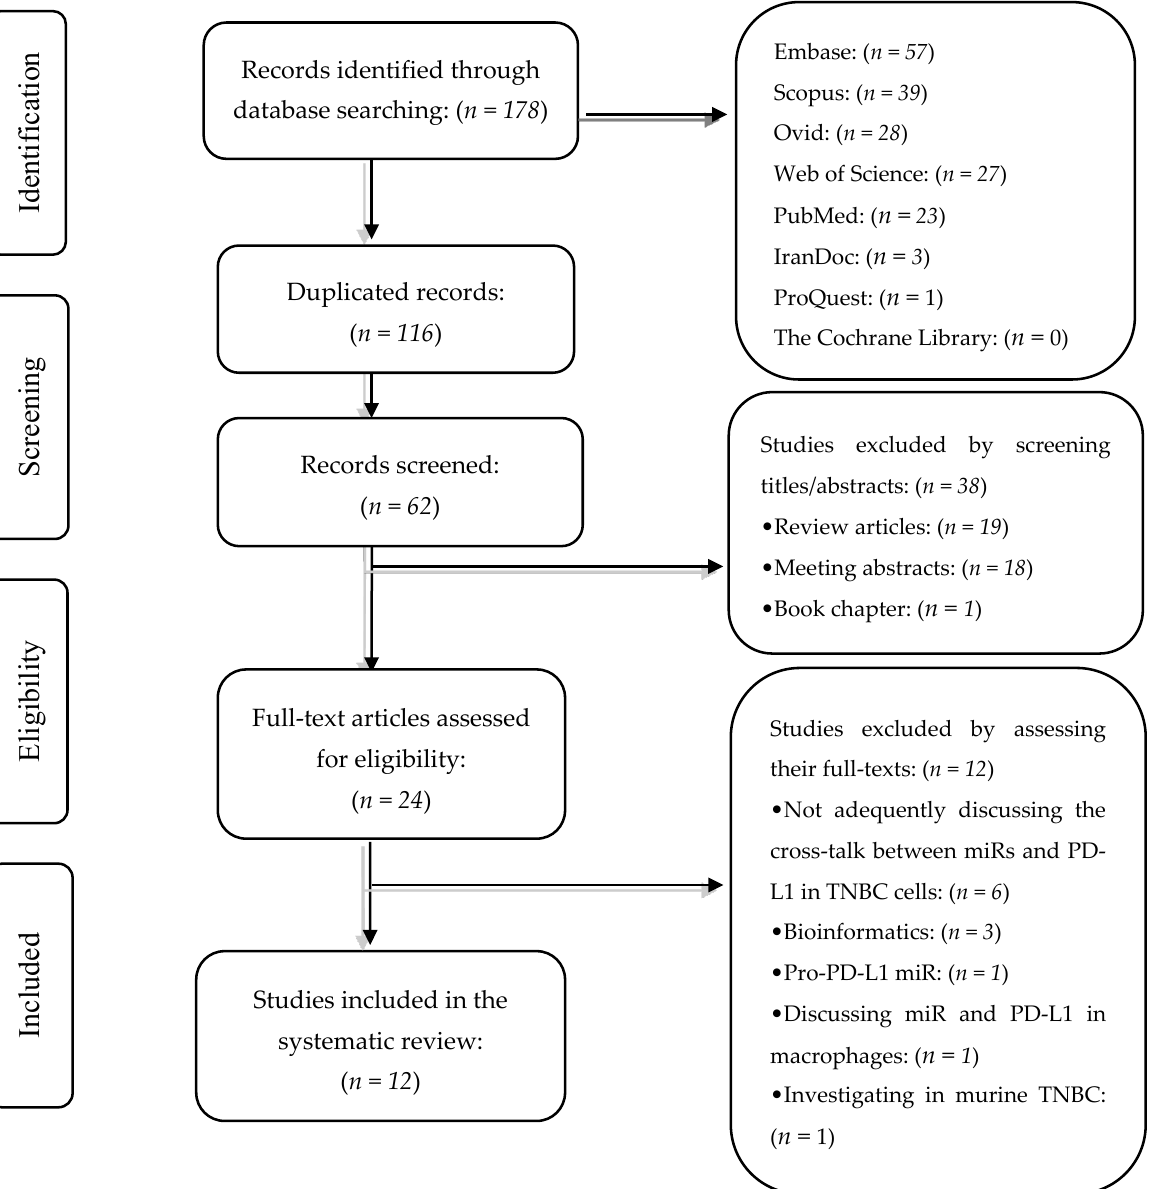
Figure 1. The flowchart of the study selection process.